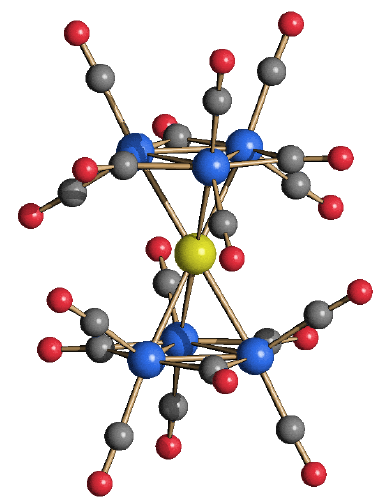
Figure 9. Molecular structure of the [Au{Co 3 (CO) 7 } 9 ] − ( 7 ) anion as found in Na 2 ( 7 )( 6 )·6H 2 O. Sub Van der Waals Au ··· C(O) contacts are represented as fragmented lines (yellow, Au; blue, Co; red, O; grey, C). Selected bond distances (Å): Au-Co 2.6284(6), 2.6307(7) and 2.6544(8); Co-Co 2.4597(10), 2.4706(11) and 2.4799(10).